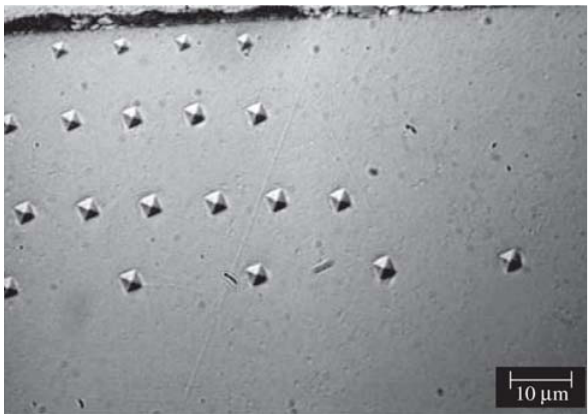
Figure 8. Vickers impressions taken beneath the nitrided layer of a H13 tool steel specimen. Load = 50 mN.